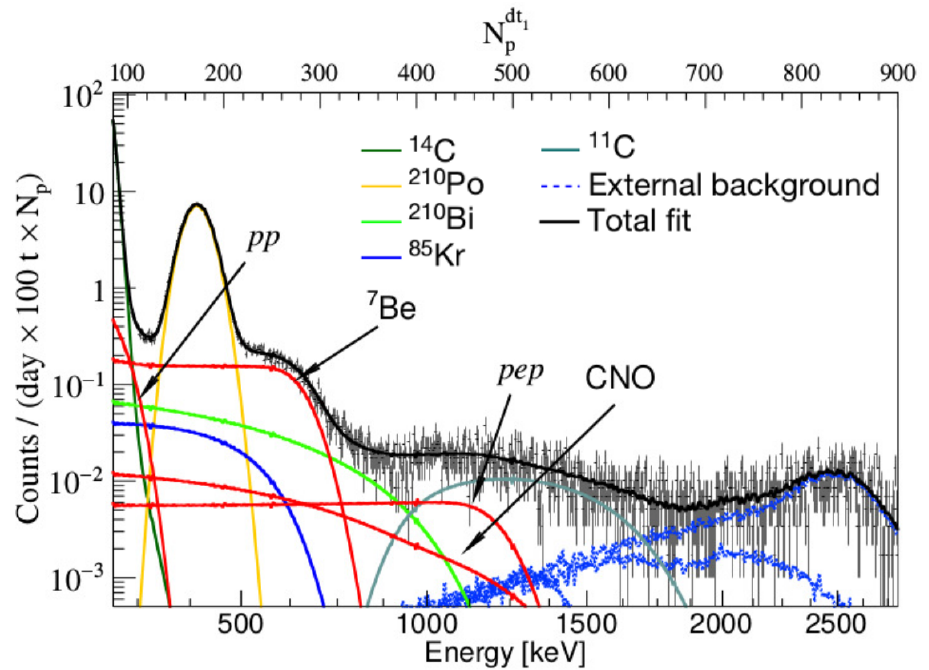
Figure 4 . Example of (cid:12)t of the Borexino energy spectrum. The (cid:12)t was performed using the N dt 1 energy estimator. The bottom horizontal axis has been converted from N dt 1 N p is a number of photoelectrons in the acquisition time